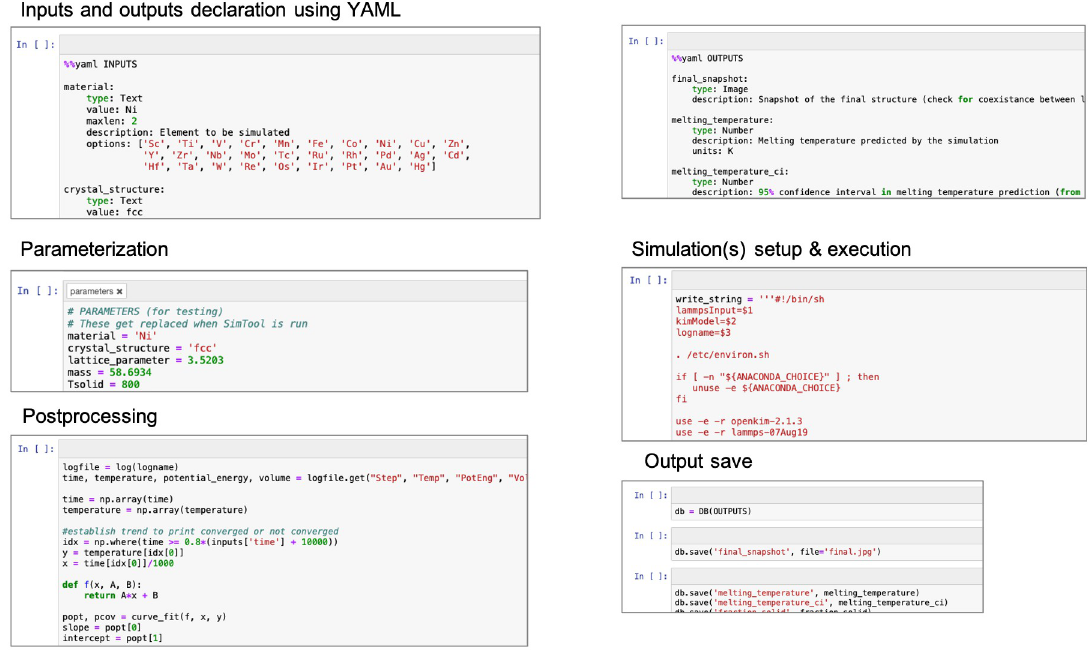
Fig 2. Elements of a Sim2L